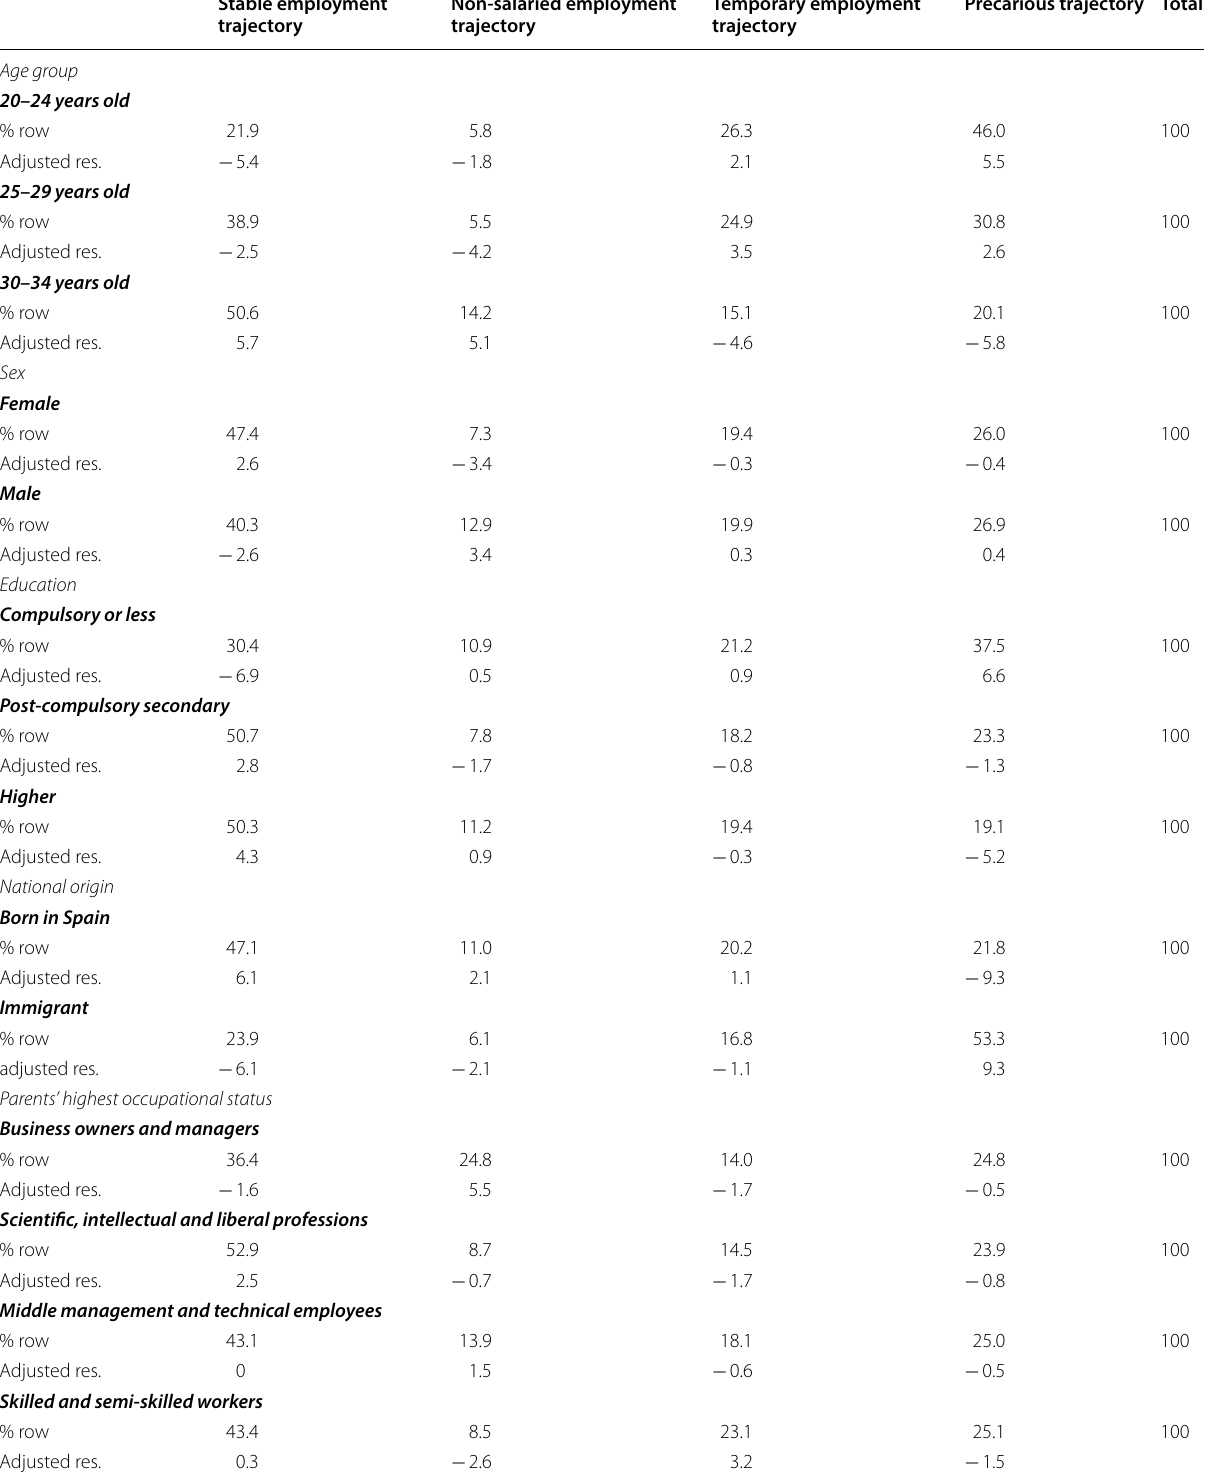
Table 7 Characteristics of age, sex, educational level, national origin, parents’ highest occupational status and characteristics of the trajectory prior to the recession by type of trajectory Stable employment Non-salaried employment Temporary employment Precarious trajectory trajectory trajectory trajectory